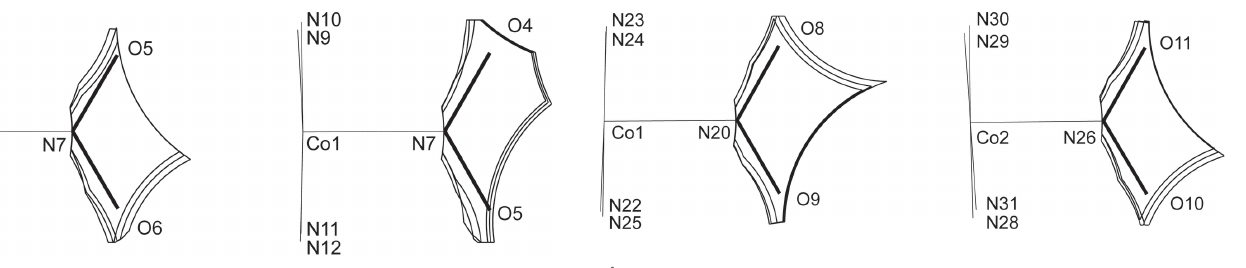
Figure 10 The slices of the cavity in (III) around the nitro groups within 0.1 A˚ from the